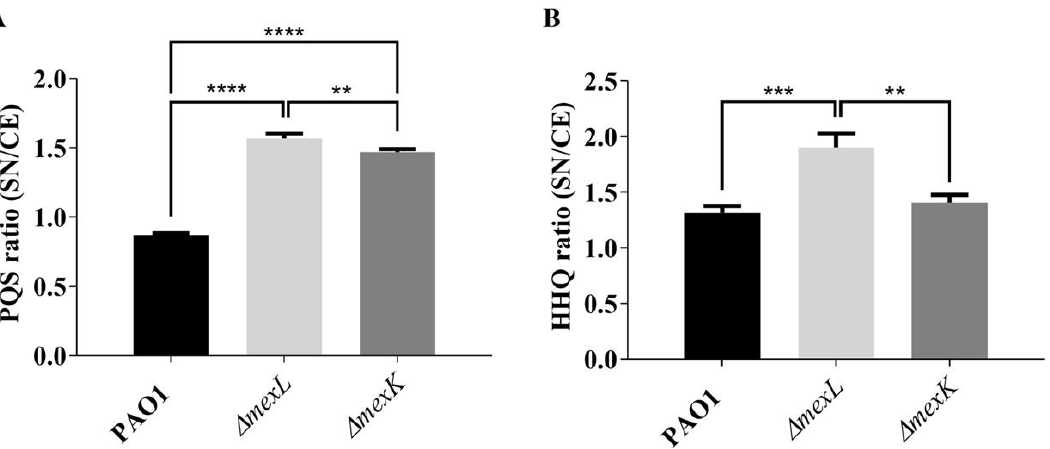
Figure 6. Determination of the ratio supernatant/cell extract (SN/CE) of PQS and HHQ. The TLC- spots corresponding to ( A ) PQS and ( B ) HHQ were quantified by densitometry using the ImageJ software, and the ratio between the HHQ and PQS present in the supernatant with respect to cell extract was calculated. The results showed that, although ∆ mexL presented a higher PQS and HHQ ratio with respect to PAO1, only the HHQ ratio could be interpreted as a consequence of efflux pump overexpression. Values that are significantly different by an unpaired two-tail t -test are indicated by asterisks as follows: ** p < 0.01; *** p < 0.001; **** p < 0.0001.